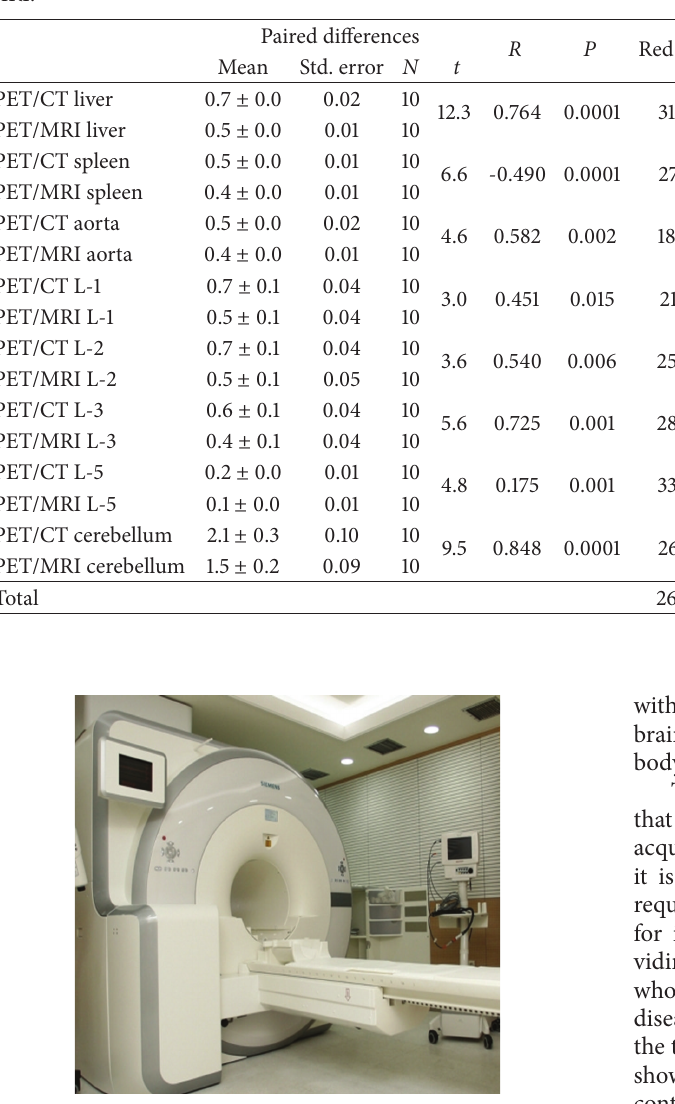
Table 9: According to noncontrast media or contrast media used, SUV